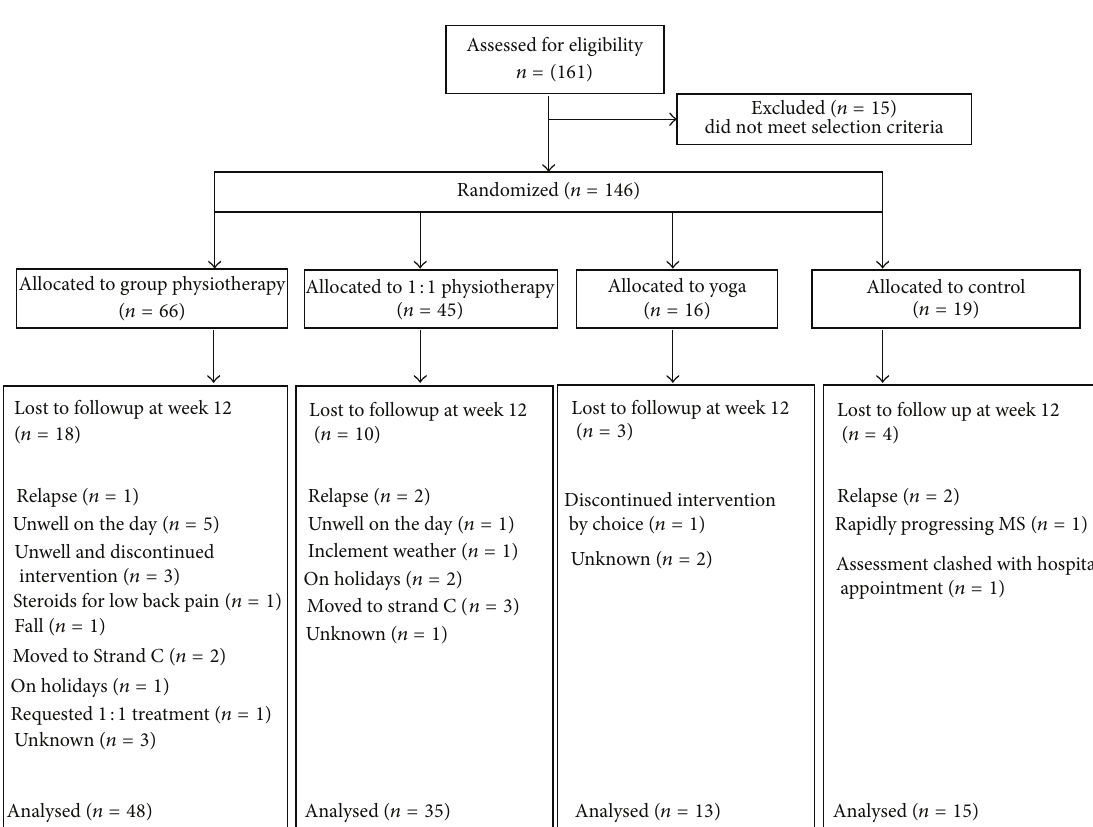
Figure 1: Flow of participants through the